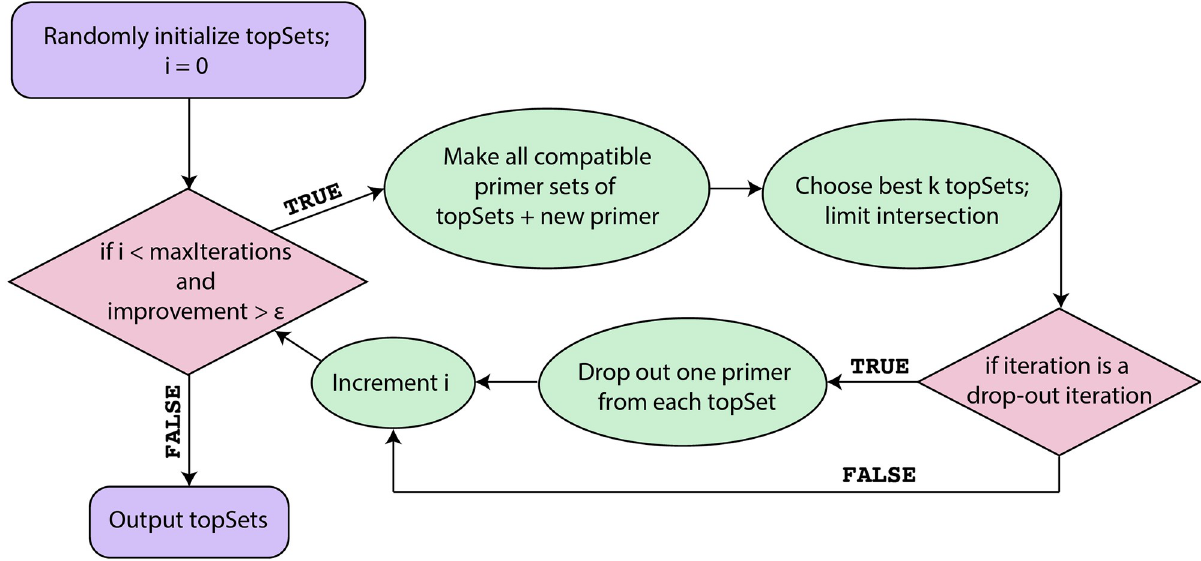
Fig 2. Summary schematic of Stage 4 (Primer set search and evaluation) of the swga2.0 pipeline. Stage 4 begins with one randomly selected primer for each primer set. Each primer set is built in parallel until the improvements in evaluation score no longer exceed a user-defined parameter ( � ) or until the maximum number of iterations is reached. A drop-out iteration forces each of the highest-scoring primer sets of size n to reduce to the subset of size n − 1 with the highest computed score.